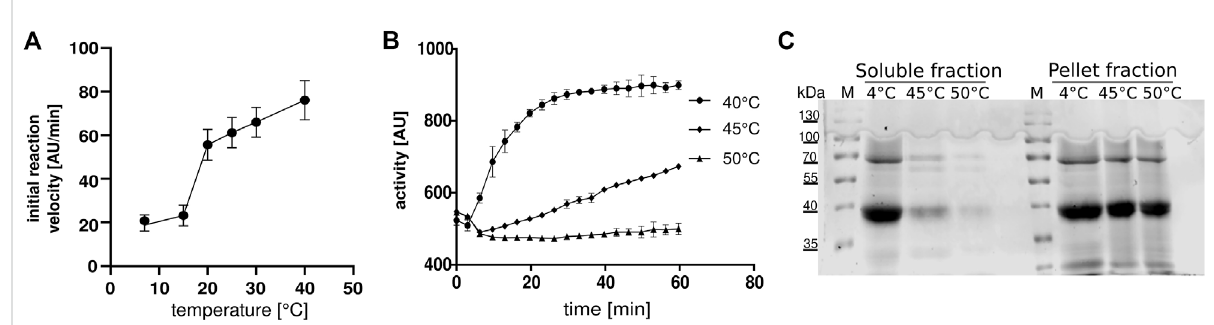
FIGURE 1 Temperatureoptimumof ce FTase (A,B) Continuous fl uorescent ce FTaseassays (A) Initial fl owdependedontemperature. (B) Activityofsamples afterheatprecipitation,measuredat45 ° Cand50 ° C,thesupernatantwasmeasuredat40 ° C. (C) SDS-PAGEafterheatprecipitation.The4 ° Cfractionis the extract after Ni-NTA compared to the soluble fraction and the pellet fraction after heat precipitation. M: marker.